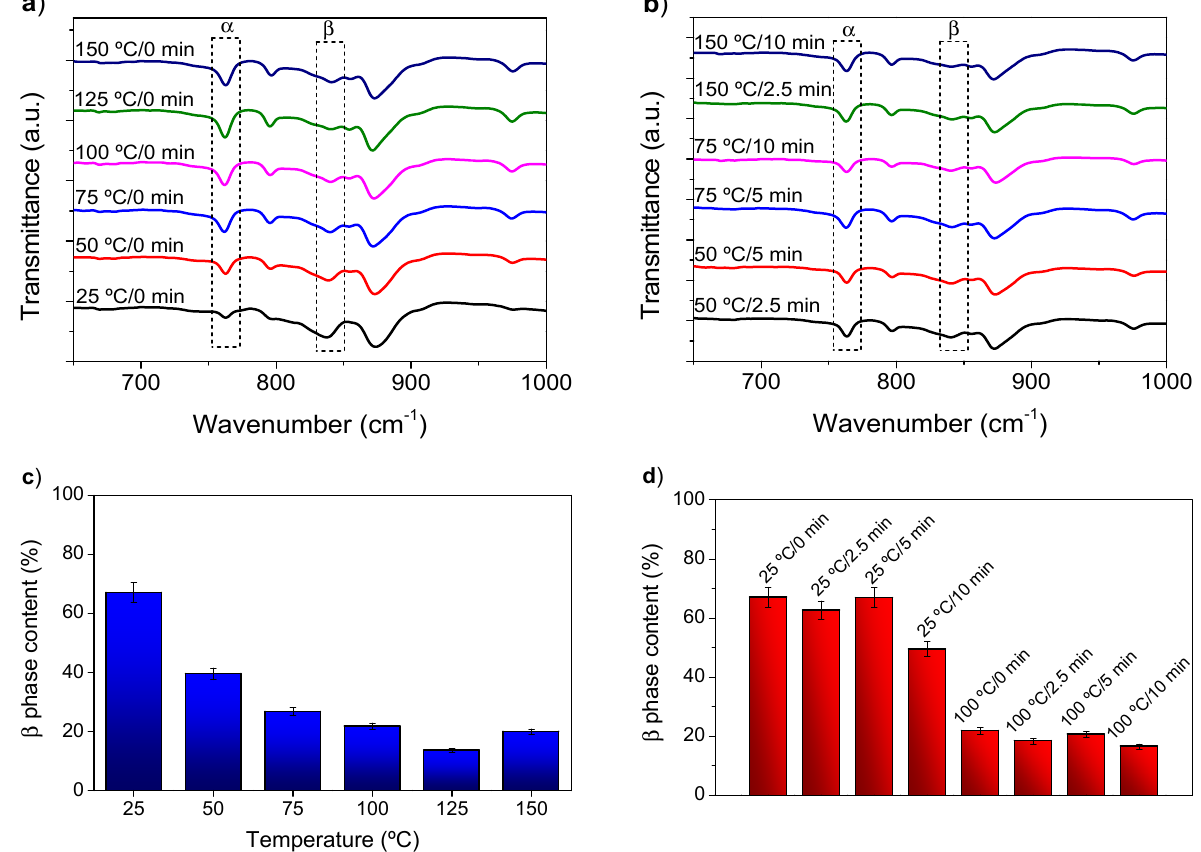
Figure 2. Representative Fourier transform infrared attenuated total reflection (FTIR-ATR) spectra of the different mem- branes as a function of: ( a ) dissolution temperature; ( b ) conditioning time and corresponding β phase content of the membranes as function of ( c ) dissolution temperature and ( d ) conditioning time.